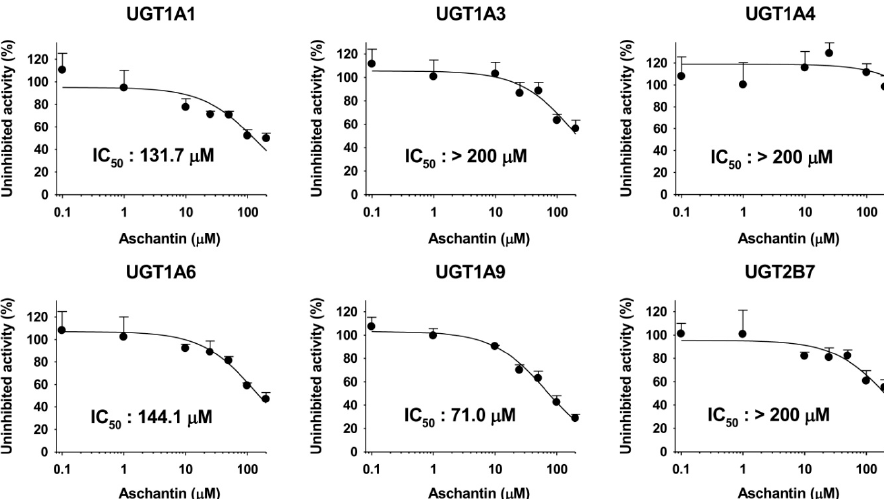
Figure 5. Inhibitory effects of aschantin on UGT1A1-catalyzed SN-38 glucuronidation, Inhibitory effects of aschantin on UGT1A1-catalyzed SN-38 glucuronidation, UGT1A3-catalyzed UGT1A3-catalyzed chenodeoxycholic acid 24-acyl-glucuronidation, UGT1A4-catalyzed trifluoperazine N -glucuronidation, UGT1A6-catalyzed N -acetylserotonin glucuronidation, UGT1A9-catalyzed mycophenolic acid glucuronidation, and UGT2B7-catalyzed naloxone 3- β - D -glucuronidationby pooled human liver microsomes. The data are means ˘ SDs ( n =